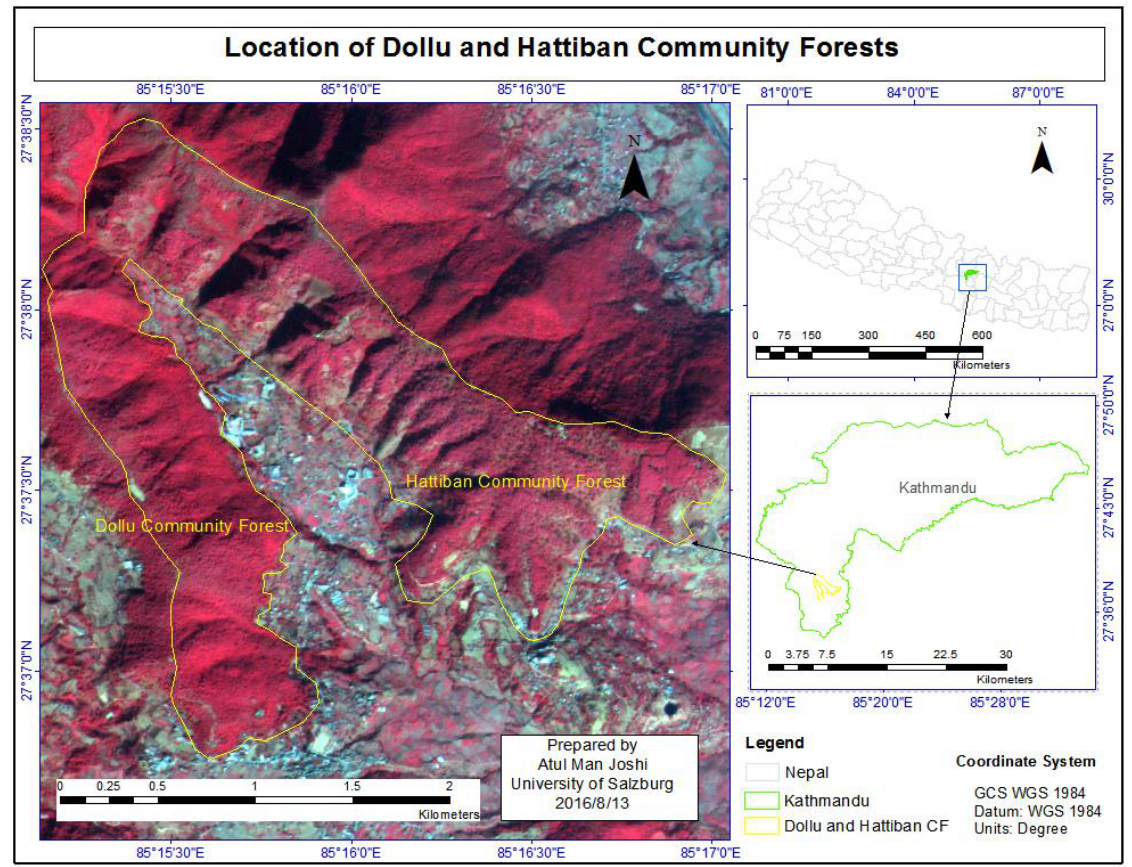
Figure 1. Location of Dallu and Hattiban Community